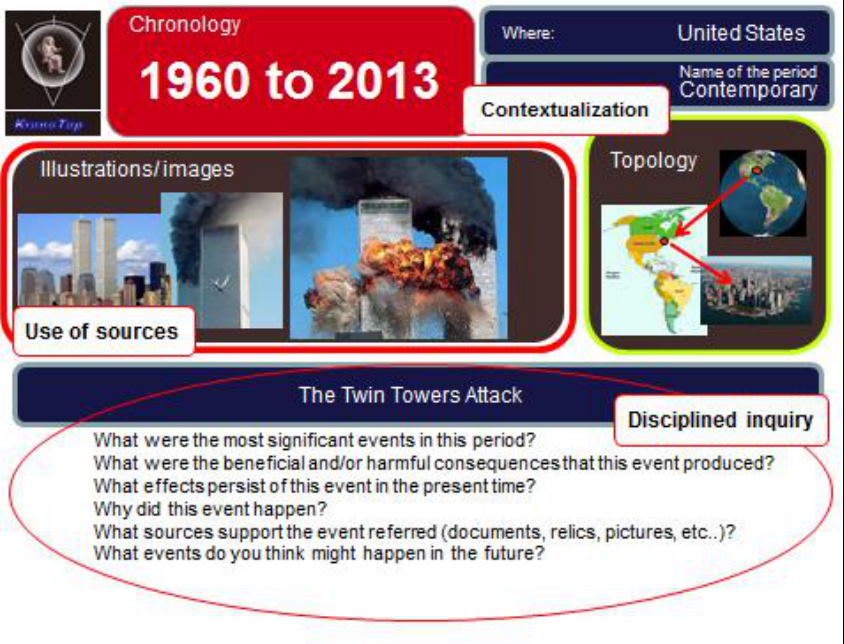
Figure 3 . KronoTop